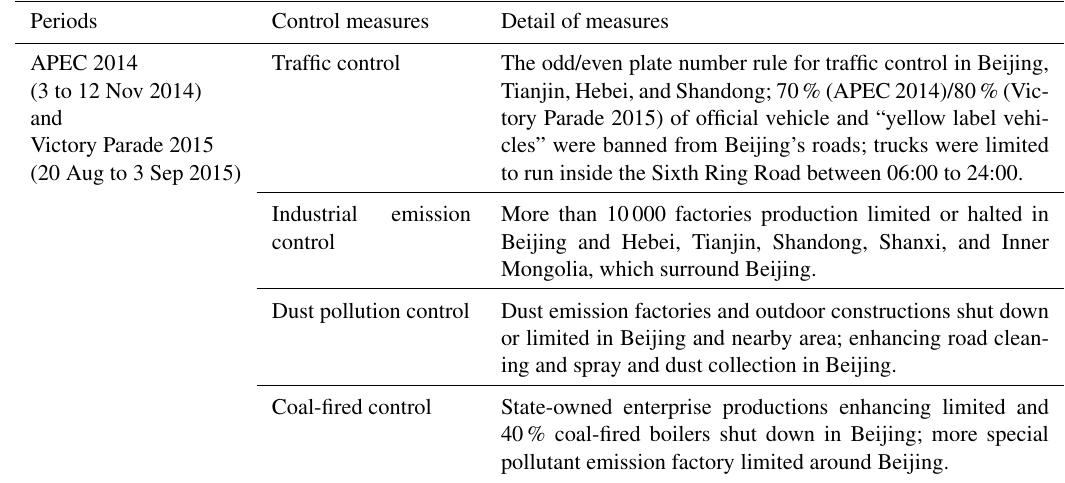
Table 2. Air pollution control strategies during APEC 2014 and Victory Parade 2015. Periods The odd/even plate number rule for traffic control in Beijing, Tianjin, Hebei, and Shandong; 70% (APEC 2014)/80% (Vic- tory Parade 2015) of official vehicle and “yellow label vehi- cles” were banned from Beijing’s roads; trucks were limited to run inside the Sixth Ring Road between 06:00 to 24:00. More than 10000 factories production limited or halted in Beijing and Hebei, Tianjin, Shandong, Shanxi, and Inner Mongolia, which surround Beijing. or limited in Beijing and nearby area; enhancing road clean- ing and spray and dust collection in Beijing. 40% coal-fired boilers shut down in Beijing; more special pollutant emission factory limited around